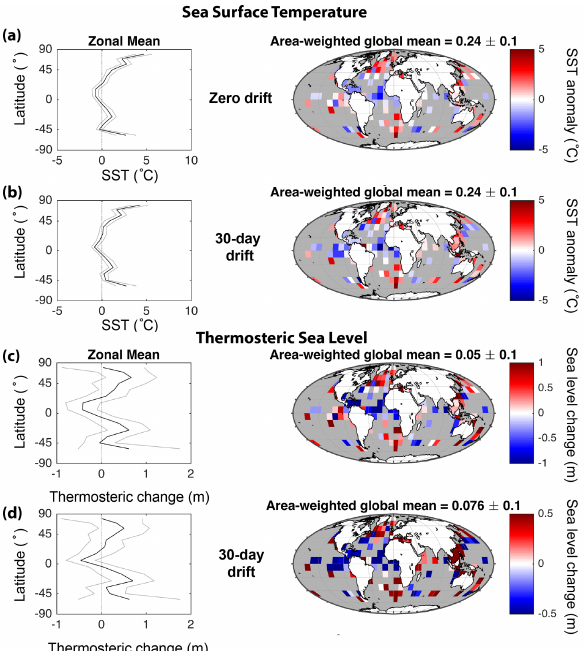
Figure 5. Global and zonal mean annual sea surface temperature (SST) anomalies and SST-derived thermosteric sea level change across the full Last Interglacial reported as uncorrected (panels a and c , respectively) and corrected values, i.e. after applying 30d (panels b and d , respectively) temperature offsets arising from drift with ocean currents. Uncertainty for zonal average reconstructions given at 1 σ . Here ocean warming is assumed to have penetrated to 2000m depth on average. Temperature estimates are relative to the modern period